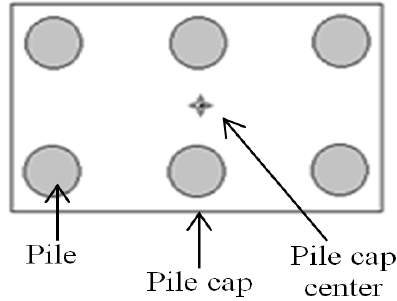
Fig. 2. Regular orientation of group of six piles at 3D spacing. ) of D in soil S 6 1000 1